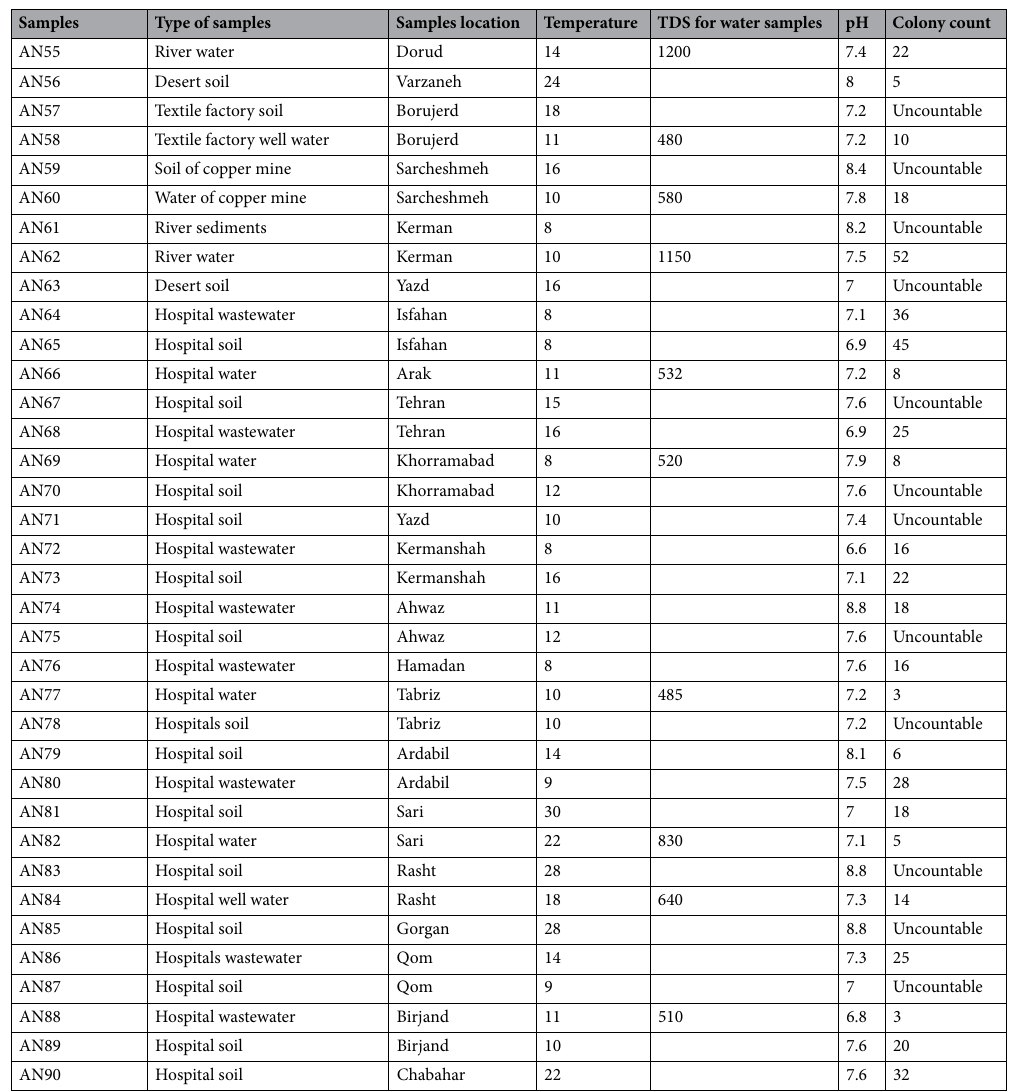
Table 1. Geographical and physicochemical features of sampling sites from Iranian